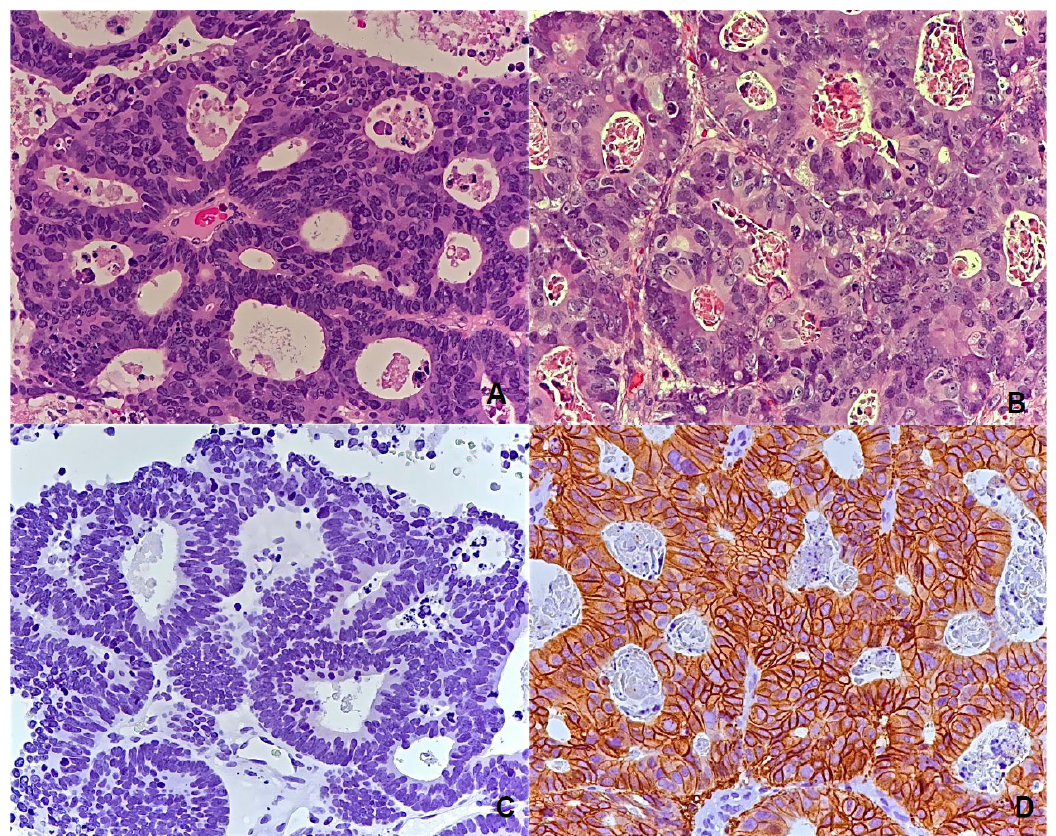
IHC HER-2 expression pattern of the BM is described in Table 4: 36 cases score 0 (72%), eight cases score 1+ (16%), two cases score 2+ (4%) and both had FISH gene amplification, and four cases score 3+ (8%). Figure 1 shows the comparison of the HE and IHC slides for HER-2 score 0 and 3+. Figure 1. Hematoxylin-Eosin colorectal specimens ( A ) and paired immunohistochemical HER-2 staining scored 0 ( C ); Hematoxylin-Eosin colorectal specimens ( B ) and